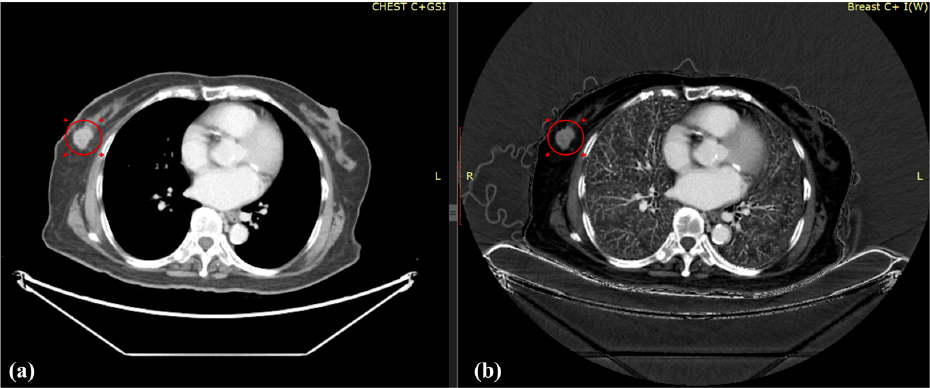
Figure 3. ( a ) Monochromatic spectral image and ( b ) iodine map for a 45-year-old patient with breast cancer and breast density of 54%; the average T/B, T/M, and CNR b were ( a ) 2.68, 1.15, and 7.65, respectively, and ( b ) 7.88, 1.59, and 14.81, respectively.